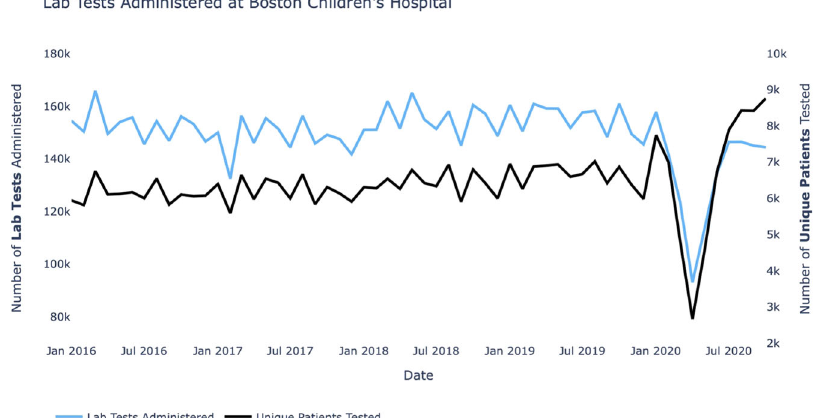
Fig. 1 Healthcare utilization during the COVID-19 pandemic. Monthly laboratory tests administered and unique patients receiving at least one test at Boston Children ’ s Hospital from January 2016 through October